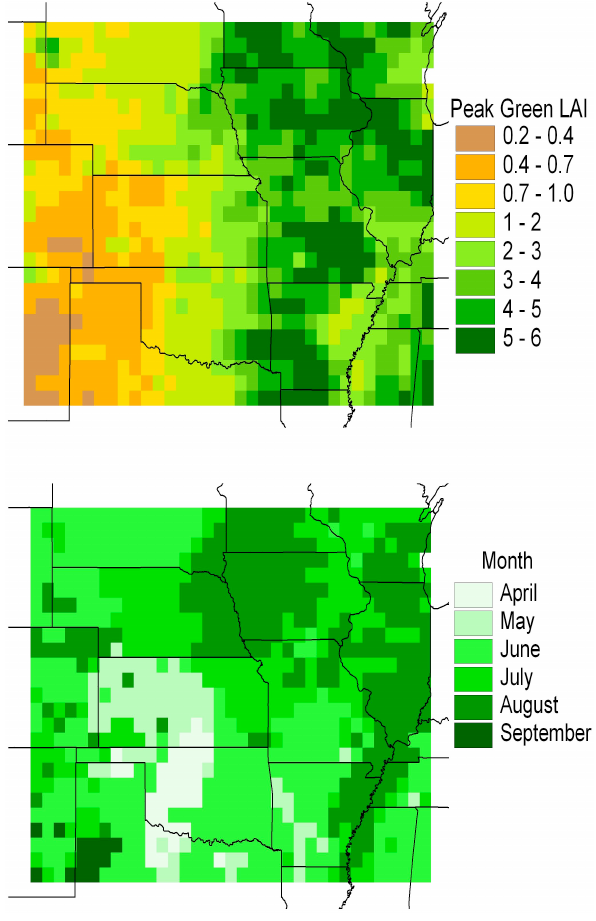
Fig. 5. (a) Correlation between January–July precipitation and July LAI from the dataset of Buerman et al. (2002) from 1981 to 1990, and (b) The coefficients of variation for July